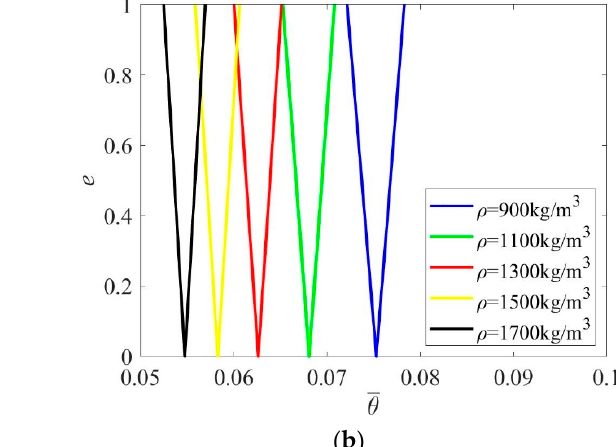
Figure 8. PIRs under different mass densities. ( a ) θ = θ L .